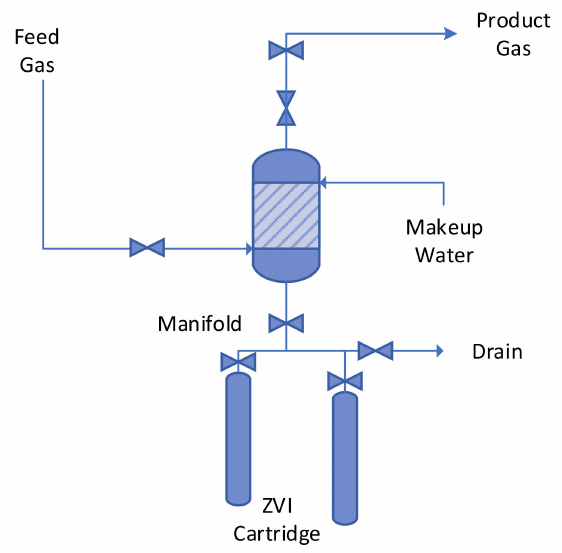
Figure 5. ZVI Reactor Process Flow Structure.